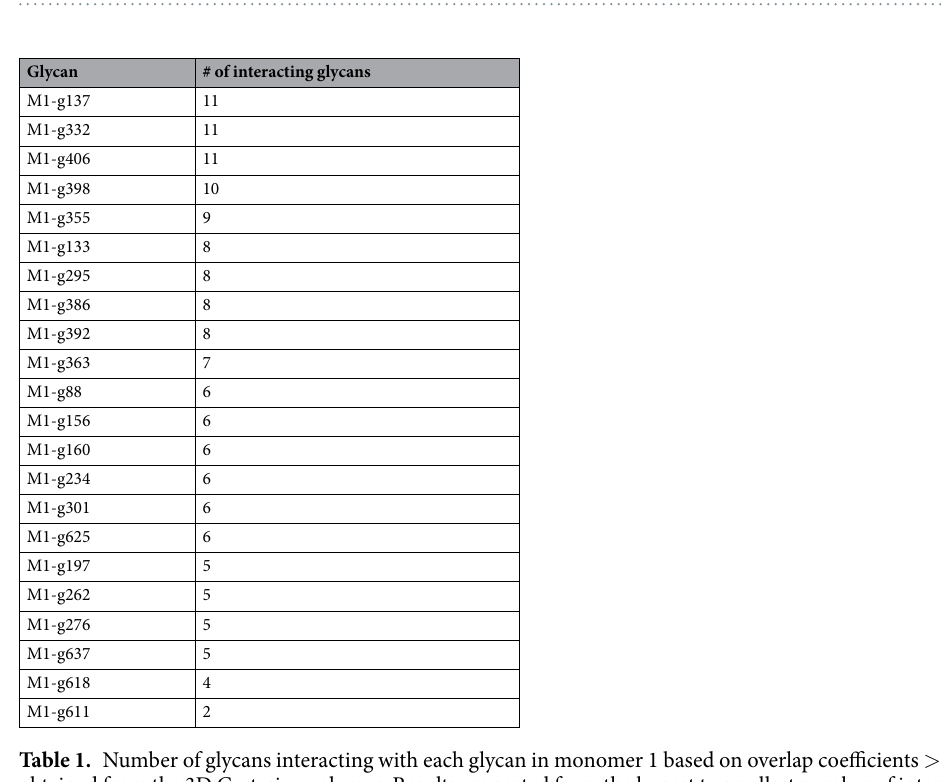
Figure 2. Sampled volume (in Å 3 ) of each glycan in the HREST-BP simulations of the Env trimer (HREST-BP/ M1, HREST-BP/M2 and HREST-BP/M3), M5 connected to Asn dipeptide (M5 * ) and the gp120 V1V2 loop (M5 ** ), M9 connected to Asn dipeptide (M9 * ) and the gp120 core (M9 ** ) models, respectively.